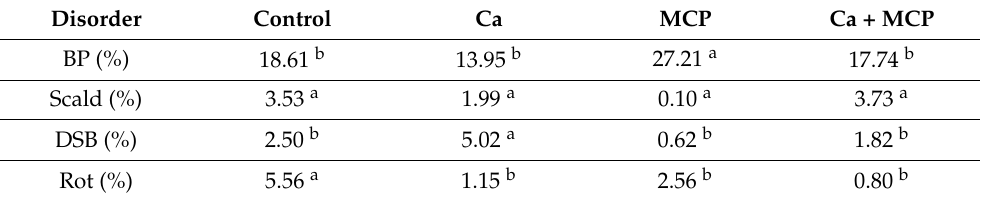
Table 1. Physiological disorders and rot in ‘Golden Delicious’ apples stored for 6 months at 0.5 ◦ C plus 7 days at ≈ 22 ◦ C, as a percentage of total fruit subjected to postharvest treatments with calcium chloride (Ca), 1-MCP (MCP), calcium chloride plus 1-MCP (Ca + MCP) and control. Disorder Control Ca MCP Ca + MCP BP (%) 18.61 b 13.95 b 27.21 a 17.74 b Scald (%) 3.53 a 1.99 a 0.10 a 3.73 a DSB (%) 2.50 b 5.02 a 0.62 b 1.82 b Rot (%) 5.56 a 1.15 b 2.56 b 0.80